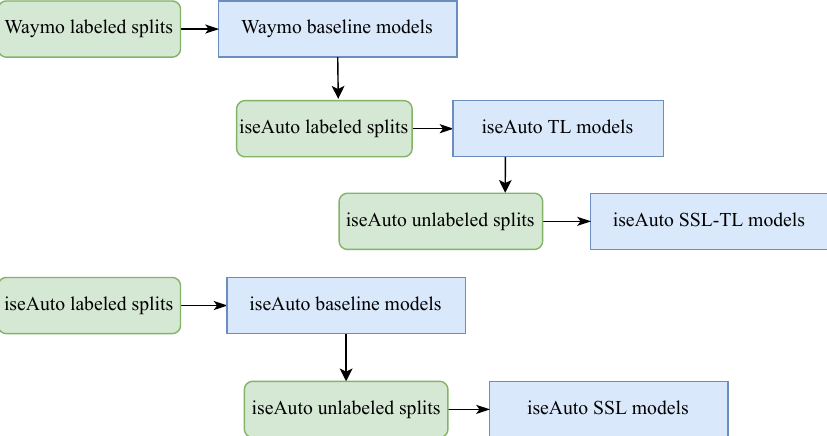
Figure 3. The workflow of the training procedures. ‘TL’ and ‘SSL’ stand for transfer learning and semi-supervised learning, respectively. ‘Waymo labeled splits’ and ‘iseAuto labeled splits’ represent the Waymo and iseAuto manual-labeled data. ‘iseAuto unlabeled splits’ means the iseAuto machine- labeled data produced by the iseAuto transfer learning fusion model. ‘Waymo baseline models’ and ‘iseAuto baseline models’ stand for supervised learning baseline models of the the Waymo and iseAuto dataset. ‘iseAuto TL models’ means the Waymo-to-iseAuto transfer learning models. ‘iseAuto SSL-TL models’ and ‘iseAuto SSL models’ are iseAuto semi-supervised learning models with and without knowledge adapted from the Waymo dataset, respectively. Please refer to Section 4.4 for further